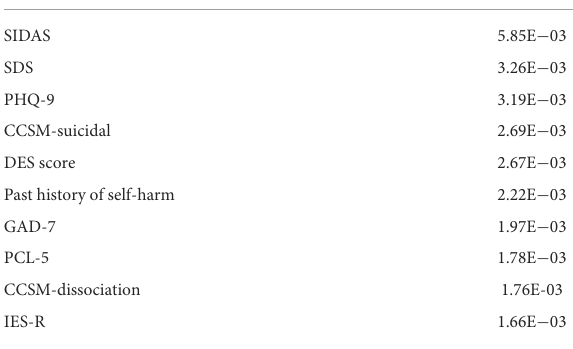
TABLE 2 Relative importance of the 10 top factors based on the suicide prediction model using measurements collected from the Time 1 responses of National Survey of Stress and Health.